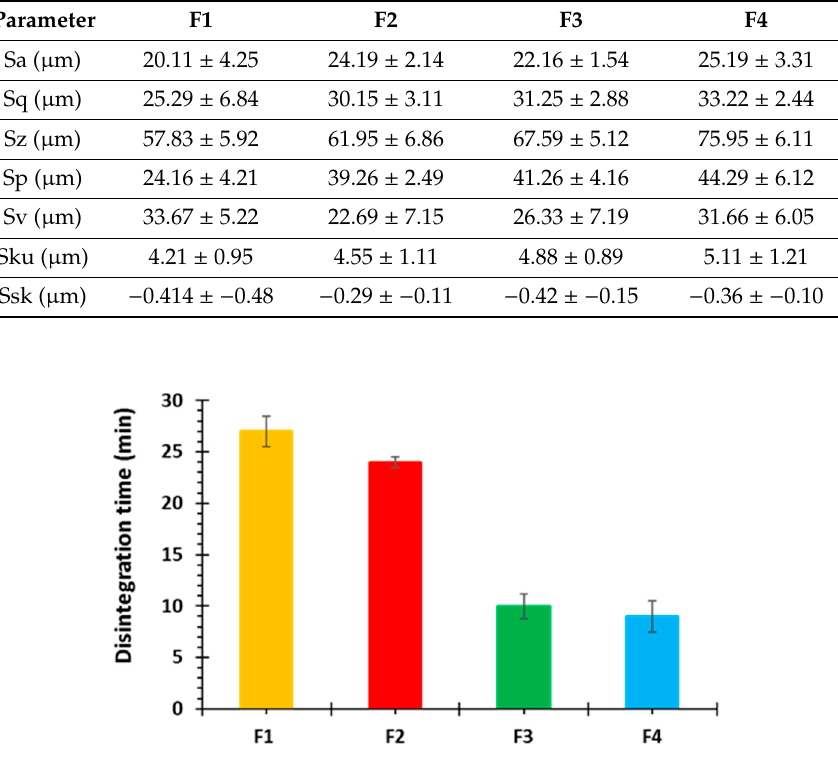
Figure 6. Disintegration profiles of 3D printed captopril tablets (n = 3).